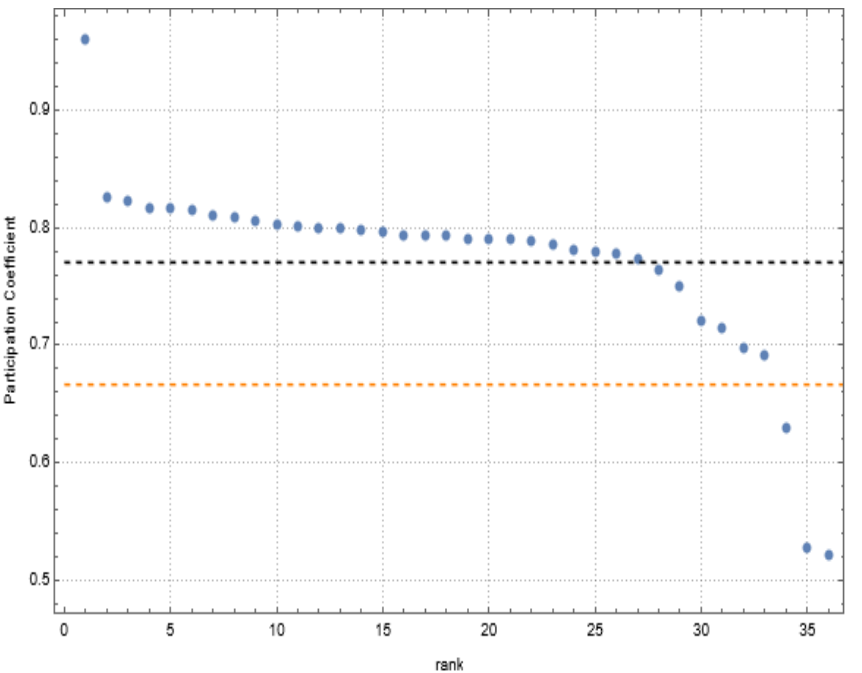
Figure 3. Rank distribution of participation coefficients (blue dots). Note: The orange-dashed line represents focus boundary, and the black-dashed line represents the average participation coefficient.